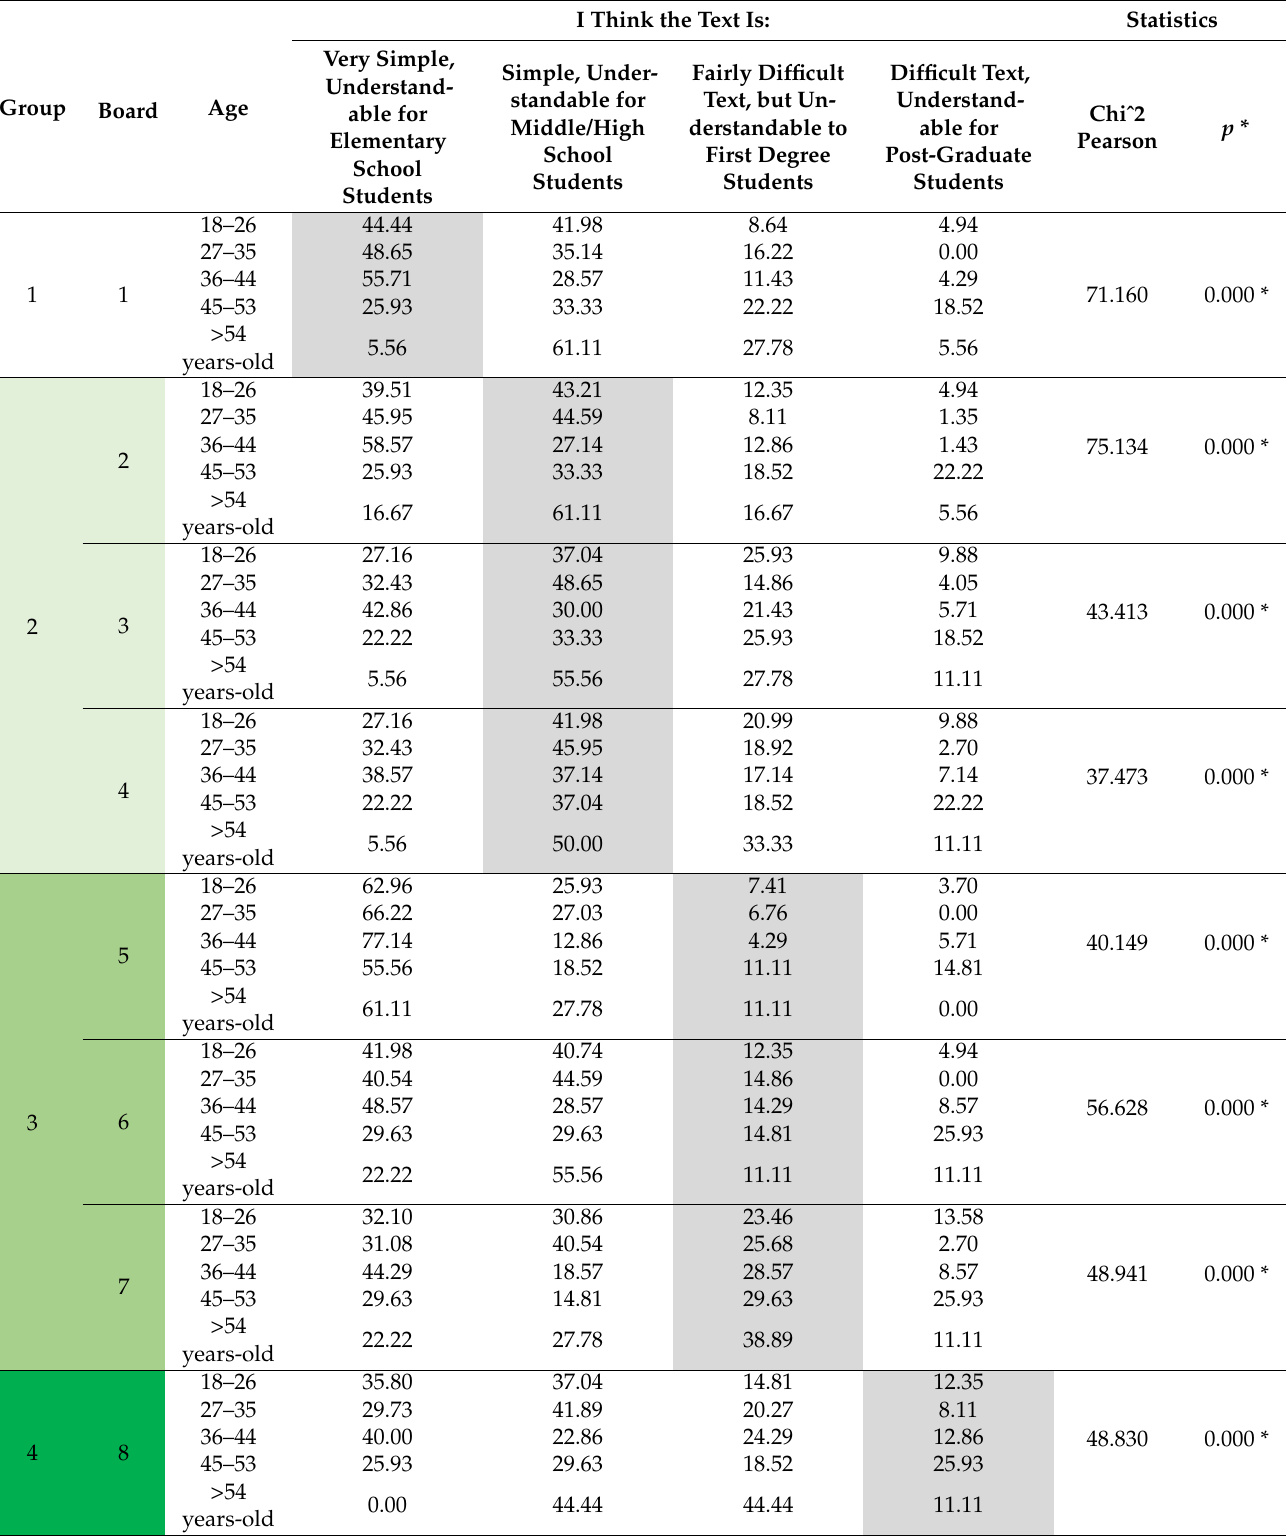
Table 8. Differences in ratings of text accessibility on educational boards by age